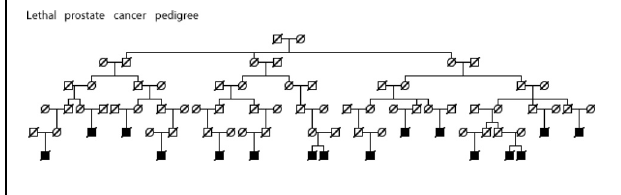
FIGURE 7 | High risk Utah prostate cancer pedigree (76 prostate cancer cases observed among descendants of the pedigree founder, 51.5 expected, p = 0 . 0008); cases known to have died from prostate cancer are